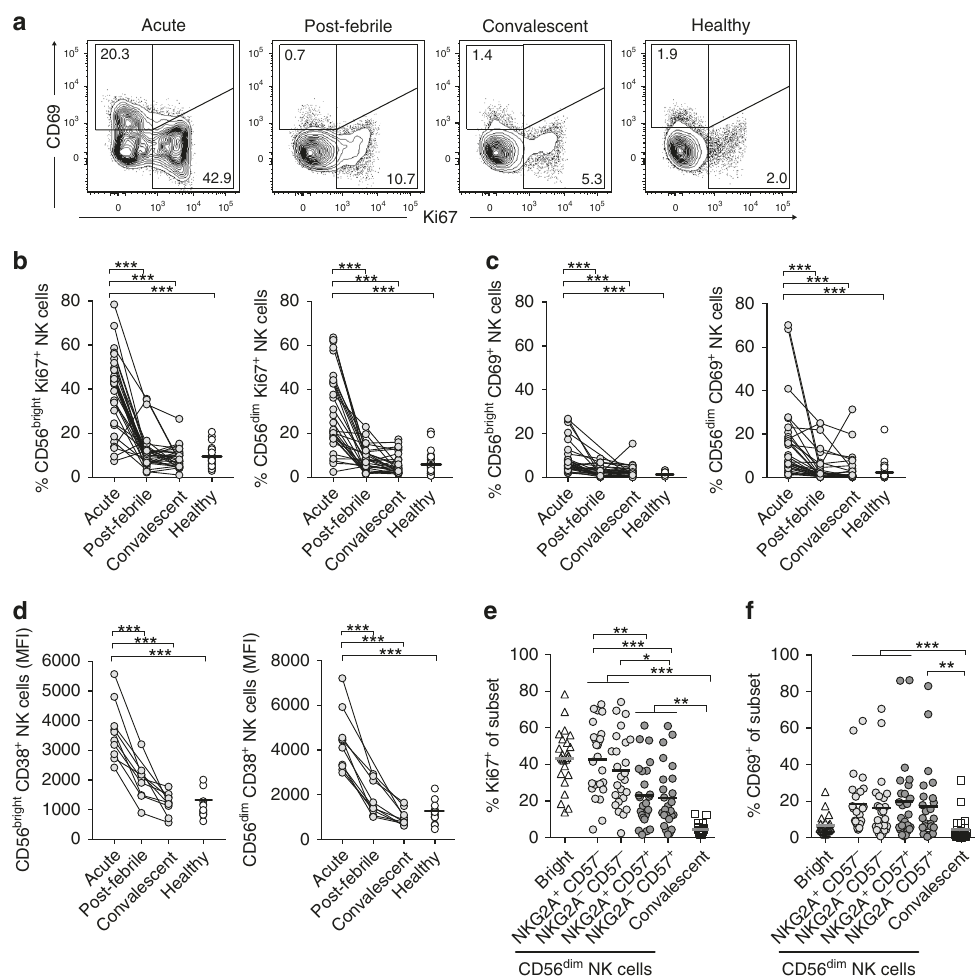
Fig. 1 Natural killer (NK) cells are robustly activated during the acute phase of dengue virus (DENV) infection. a Representative staining for CD69 and Ki67 expression on NK cells from one representative patient during the acute, post-febrile, and convalescent phase of DENV infection, and one healthy control. Summary of data showing b Ki67, c CD69 (acute, n = 31; post -febrile, n = 29; convalescent, n = 29; healthy control, n = 26), and d CD38 (acute, n = 10; post -febrile, n = 9; convalescent, n = 10; healthy control, n = 13) expression on CD56 bright and CD56 dim NK cells shown as median fl uorescence intensity (MFI), respectively. e , f Summary of data on e Ki67 and f CD69 expression on CD56 bright as well as CD56 dim NK cell subsets, respectively. The CD56 dim NK cells are strati fi ed by differential expression of NKG2A and CD57. NK cells from DENV-infected patients at the acute ( n = 25) and convalescent ( n = 23) phases of infection. Statistical differences were tested using one-way analysis of variance (ANOVA) and Kruskal – Wallis test followed by Tukey ’ s multiple comparisons test or Dunn ’ s multiple comparisons test, respectively. Bars represent mean, * p < 0.05, ** p < 0.01, *** p < 0.001. Source data